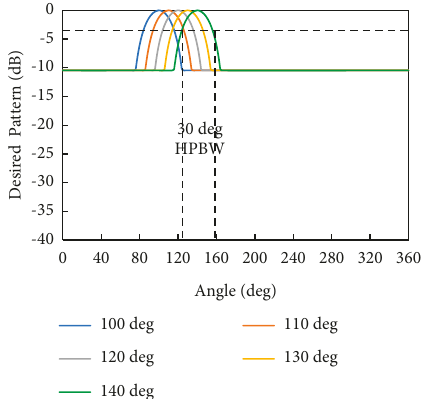
Figure 3: Desired SoI {100 ° –140 ° } with a step size of 10 ° in terms of the cosine-shaped beam pattern.